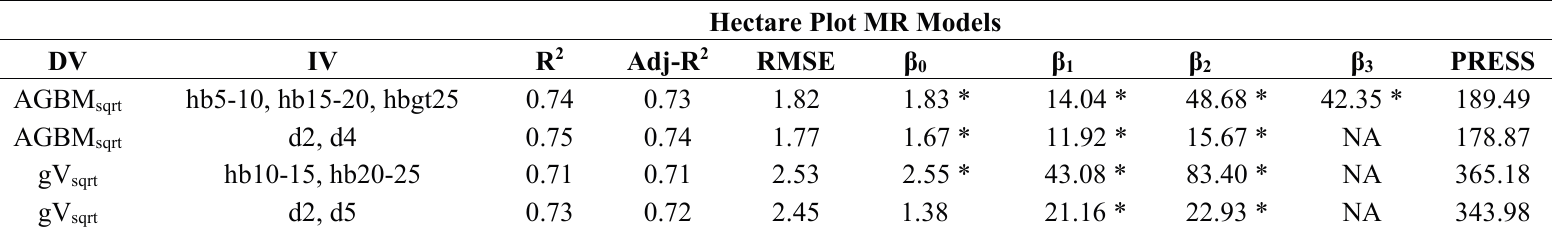
Table 12. Hectare plot-level multiple regression analysis results. * indicates p -values of less than 0.05. Hectare Plot MR